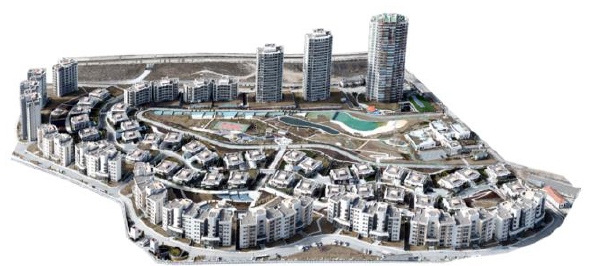
Figure 1. Sample 3D City Model.